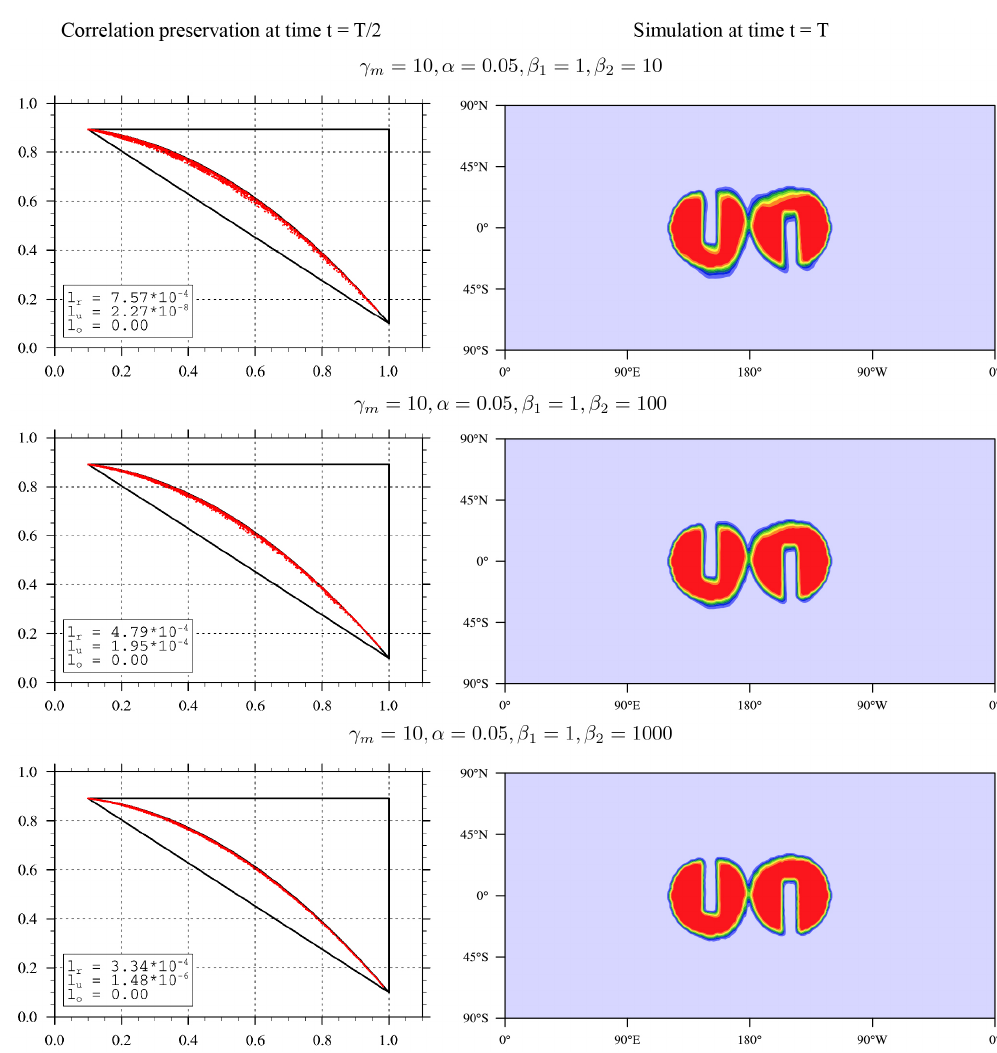
Figure 12. The effects of interparcel mixing with the slotted cylinders’ initial condition. There are three parameter configurations as shown on the top of the each row. By increasing β 2 , the lateral mixing is decreased. The results for γ m = 100 are in Figs. 10 and 11.